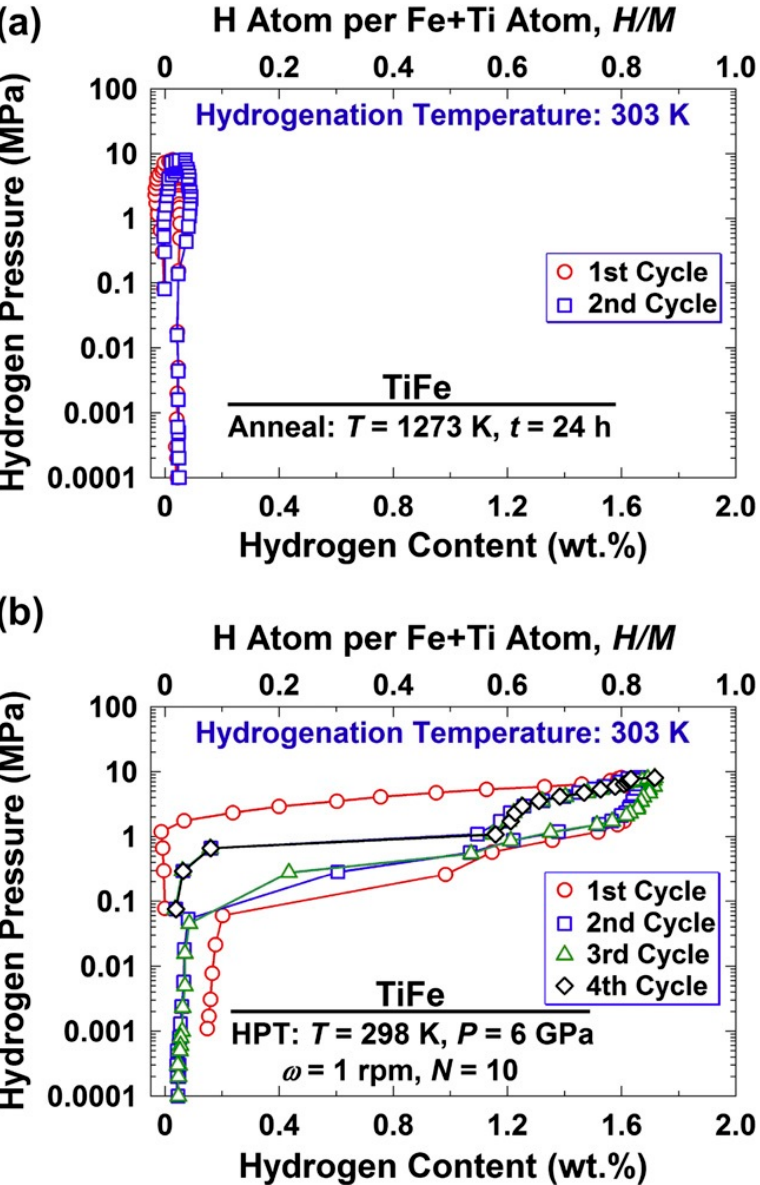
Figure 10. Pressure-composition isotherms of samples processed by ( a ) annealing under argon and ( b ) high-pressure torsion in the air [120].